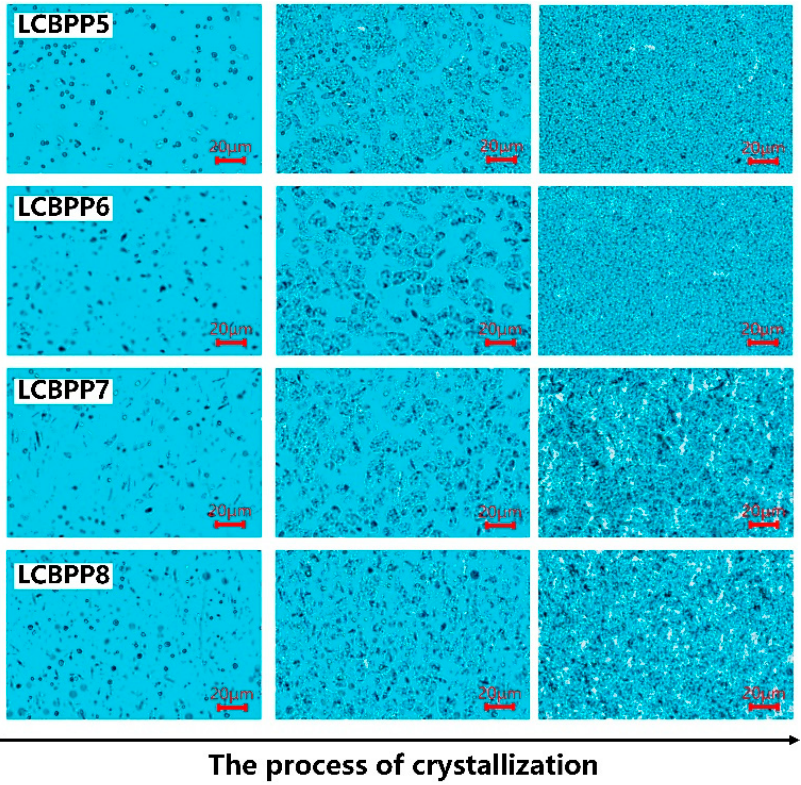
Figure 7. Crystalline morphology comparison of modified film with β nucleating agents added during the process of crystallization.